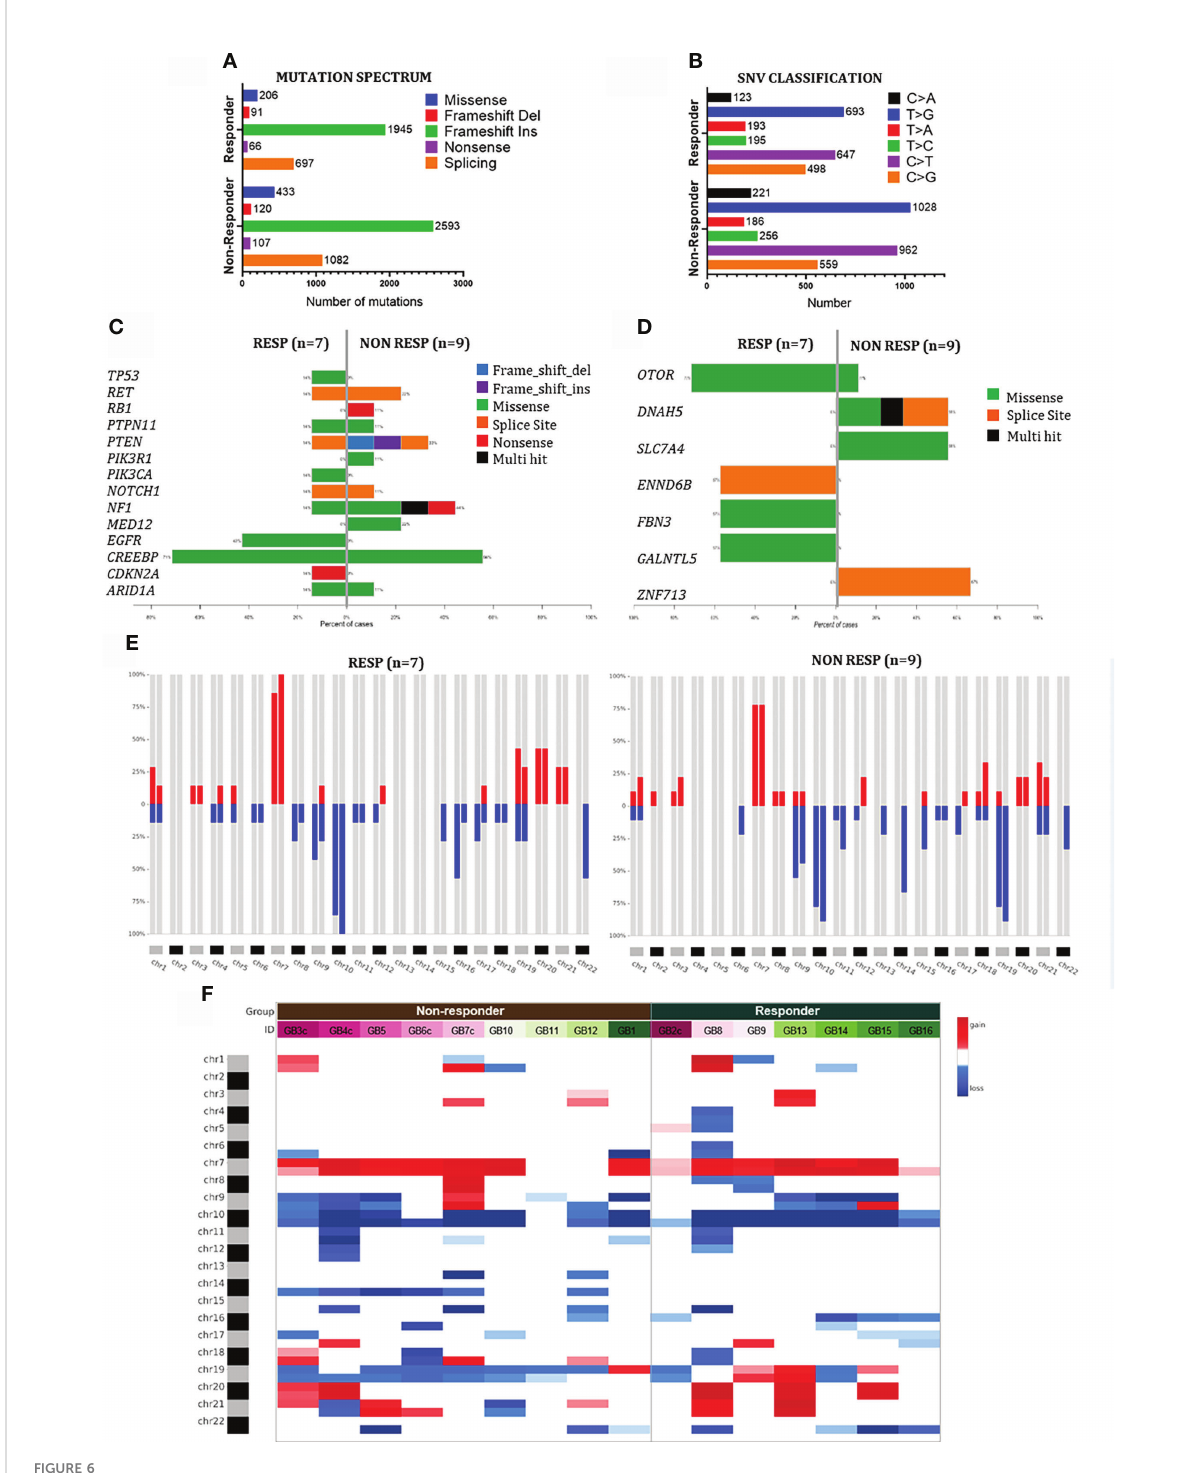
FIGURE 6 Mutational pro fi ling of GB-EXPs. (A, B) The mutation landscape of the GB cohort (n=16). Counts of each variant classi fi cation (a) and counts of each single-nucleotide variant (SNV) classi fi cation (B) . (C) Co-bar plot of the most frequent gene mutations in GB. (D) Co-bar plot of the genes signi fi cantly discriminating Non-Resp and Resp groups. (E) CNApp frequencies for the p and q arms of each chromosome in Resp and Non- Resp groups. Alteration frequency is expressed as the percentage of altered samples out of the total within each group (red for gains and blue for losses). (F) Heatmap of individual copy number region pro fi les shows changes in copy number of chromosome regions between Resp (n=7) and Non.Resp (n=9) groups (red for chromosome gains and blue for